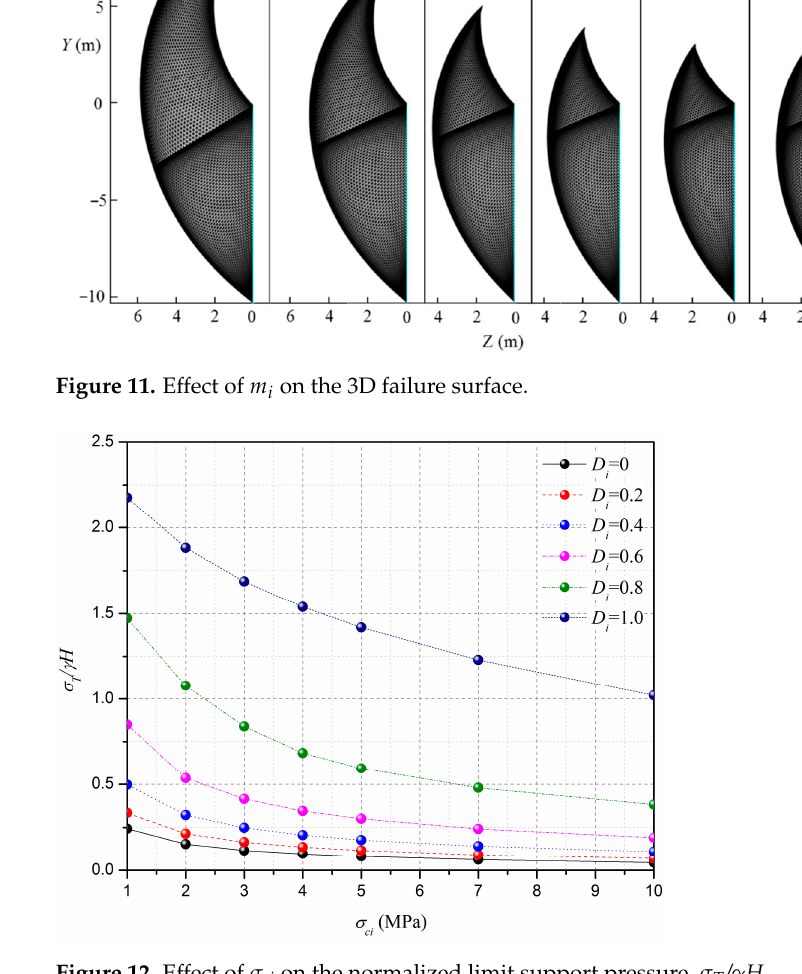
Figure 12. Effect of σ ci on the normalized limit support pressure, σ T / γ H